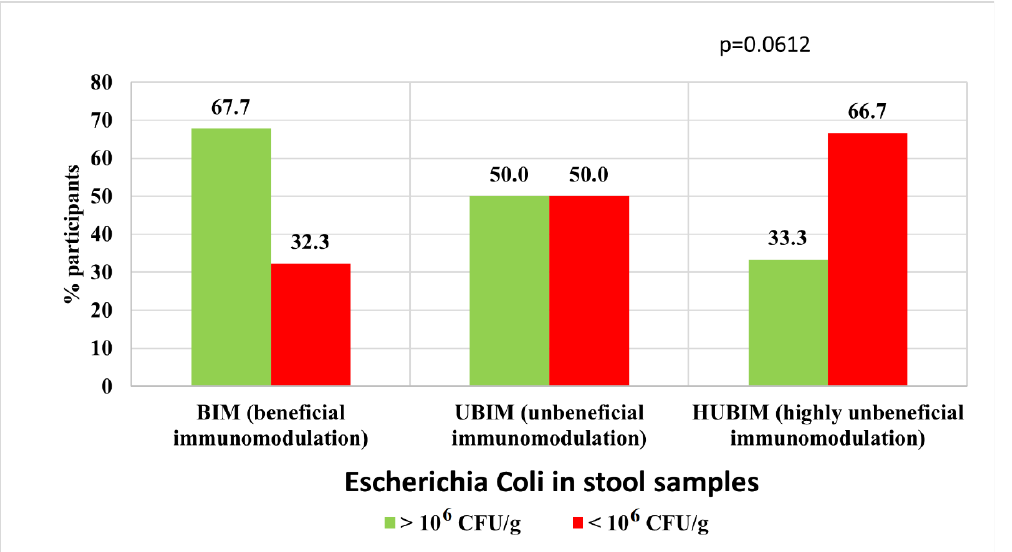
Figure 5. Relationship between an immunomodulatory diet and the amount of E. coli (immunostim- ulatory) among men.